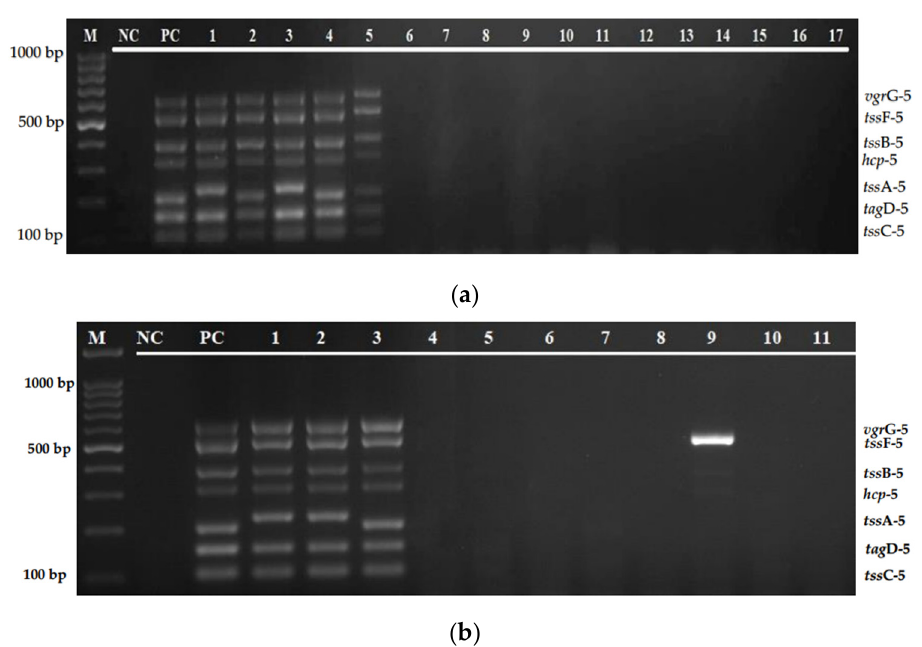
Figure 4. ( a ) Specificity evaluation of the multiplex PCR assay on B. pseudomallei isolates and other bacterial strains. Lane M: 100 bp DNA ladder; lane NC: negative control; lane PC: positive control; lanes 1–5: B. pseudomallei isolates; and lanes 6–17: S. aureus ATCC 25923, K. pneumoniae ATCC 70063, E. faecalis ATCC 29212, P. aeruginosa ATCC 27853, V. parahaemolyticus ATCC 17802, N. meningitidis 13090, E. coli ATCC 35218, Streptococcus Group A, S. epidermidis , S. enterica serovar Thypimurium , Streptococcus Group B, and S. viridans , respectively. ( b ) Specificity evaluation of the multiplex PCR assay on B. pseudomallei isolates and other bacterial strains. Lane M: 100 bp DNA ladder; lane NC: negative control; lane PC: positive control; lanes 1–3: B. pseudomallei isolates; lanes 4–6: S. maltophilia isolates; lanes 7–11: H. pylori , E. faecalis , V. cholerae , Salmonella sp., and P. mirabilis , respectively.